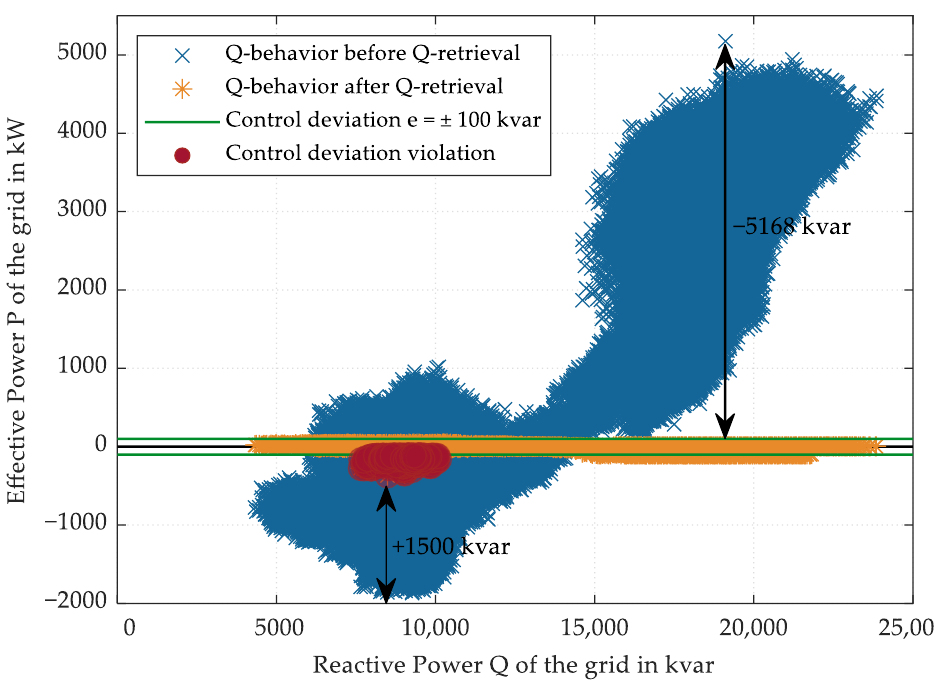
Figure 9. P–Q behavior of the regarded medium-voltage grid (logged at the low-voltage site of the substation transformer) before (blue) and after (orange) the reactive power retrieval by the central reactive power control strategy with red circled data points, which exceed the control deviation (green).